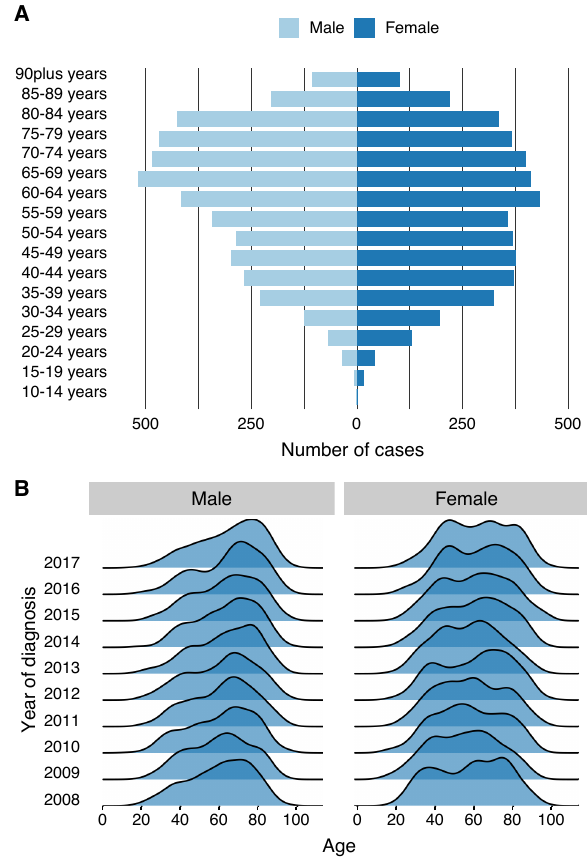
Figure 4. Pyramid plot in ( A ) shows that cases occur at younger ages in women showing a double peak of incidence; however, in men they present in a single peak of incidence at older ages. ( B ) shows a ridgeline with the distribution trend across the years of the